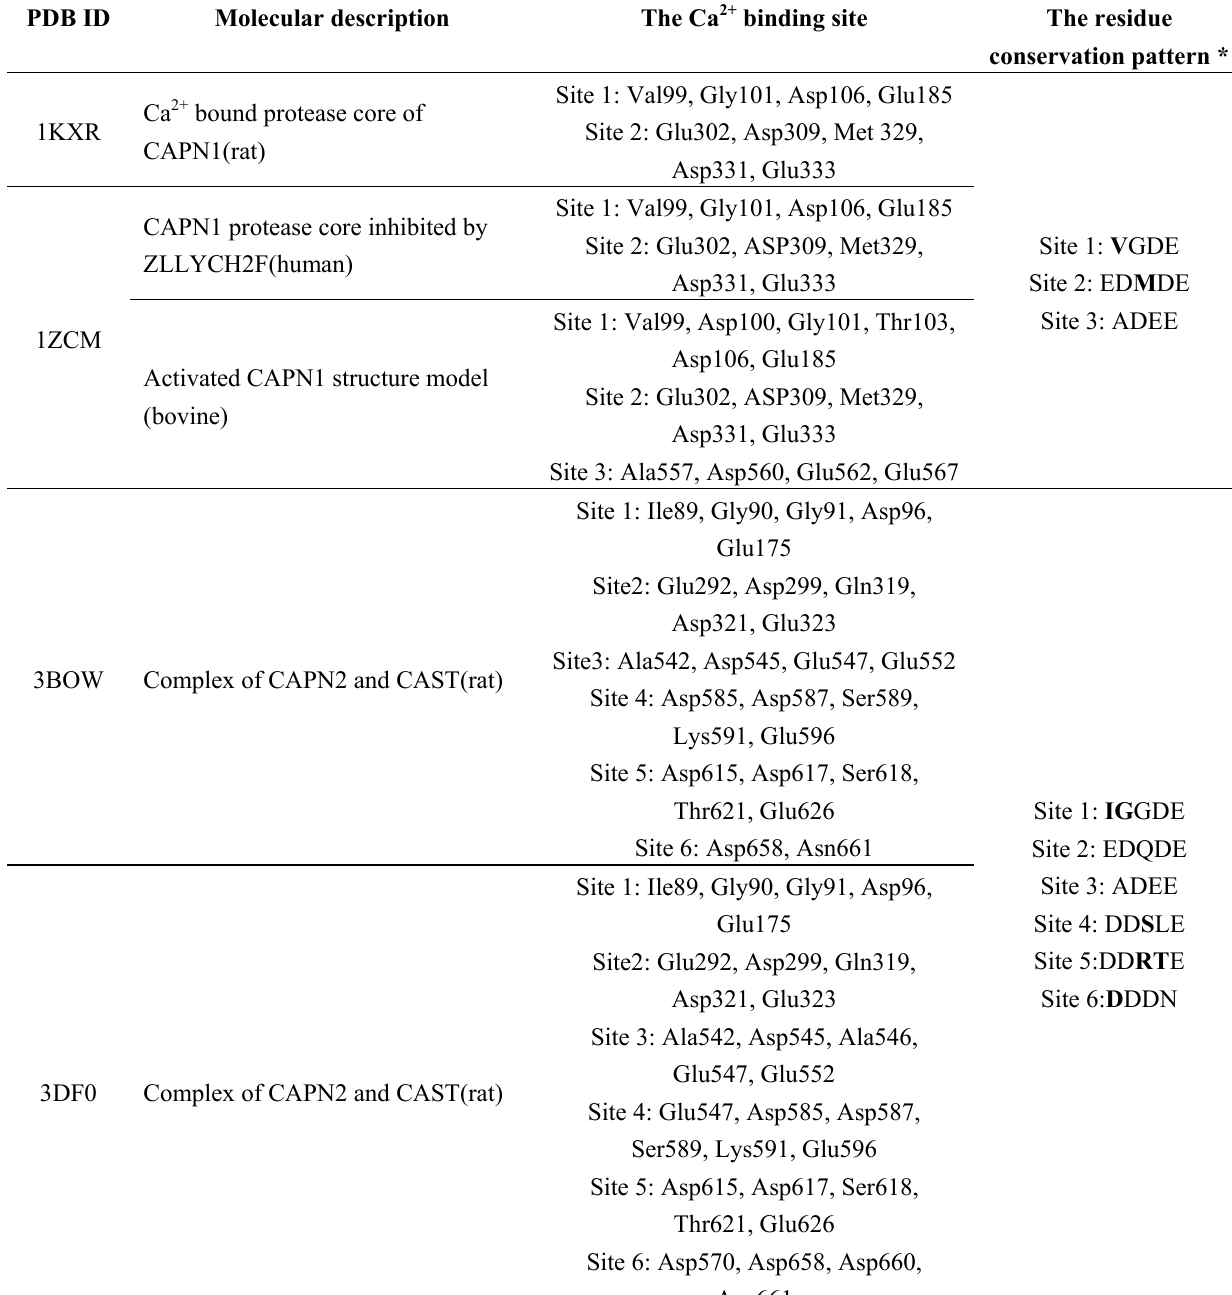
Table 3. The conserved Ca 2+ -binding site in CAPN large subunit (DI-DIV) with protein